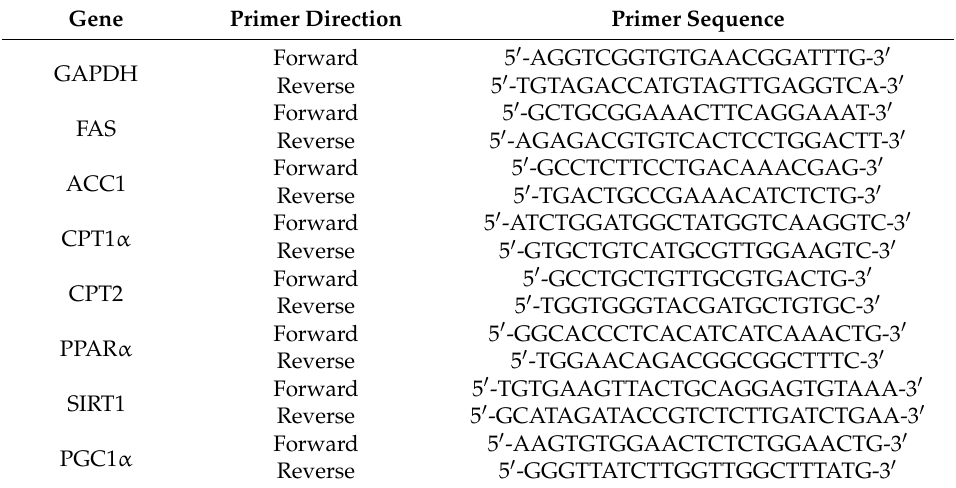
Table 2. Primer sequences used for RT-qPCR validation of the microarray